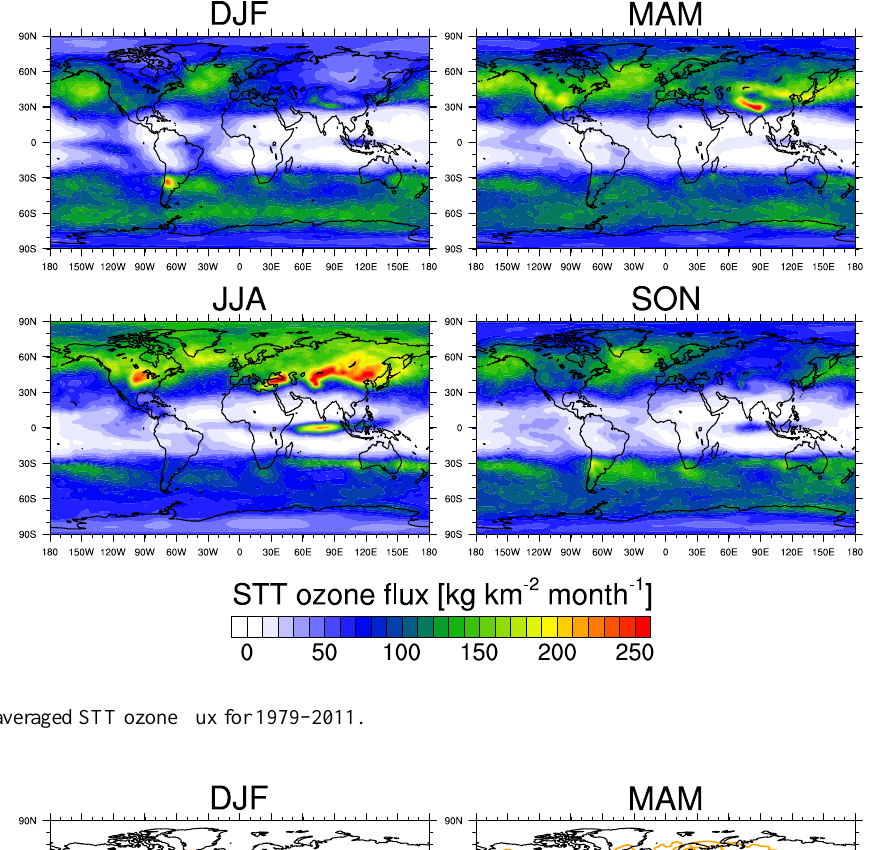
Fig. 16. Seasonally averaged STT ozone flux for 1979–2011.